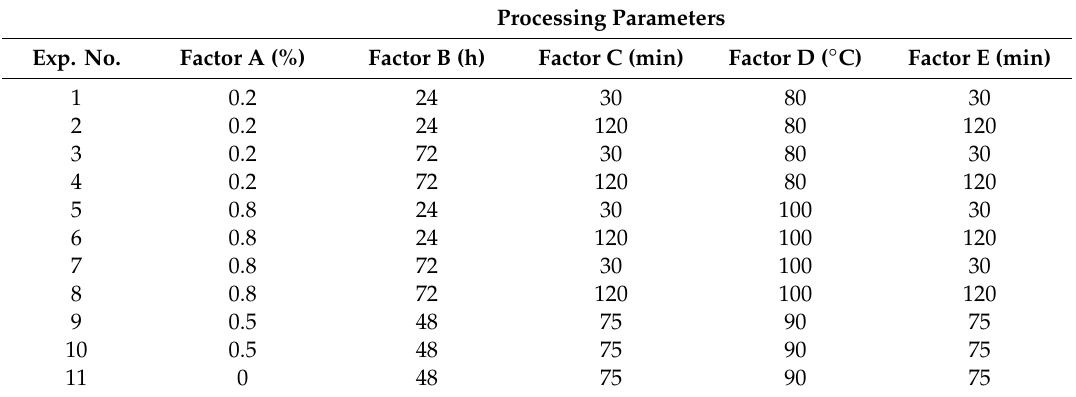
Processing Parameters